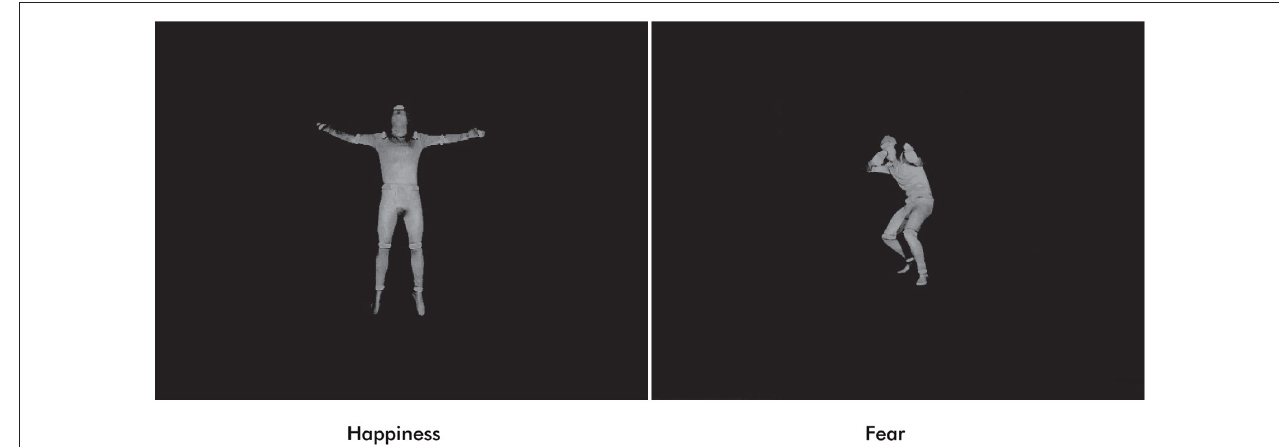
FIGURE 1 | Examples of full-light static body expressions of happiness and fear